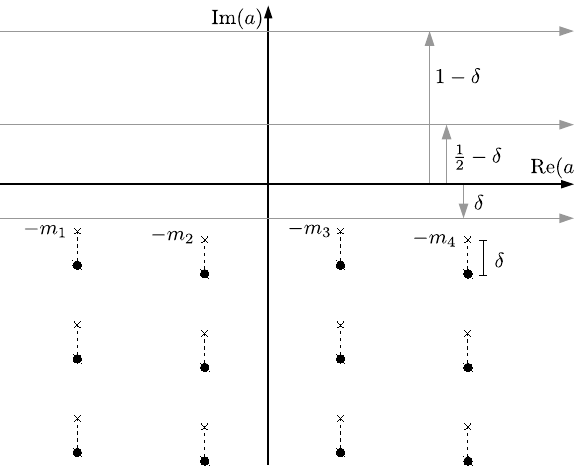
Figure 2 . The insertion of vortex defects shifts the poles of the integrand in the negative imaginary direction by (cid:14) . The triviality of defect correlators in this theory can be shown by shifting the contour of a -integration below the real axis by (cid:14) . The shifts of contour in the other direction are also shown.